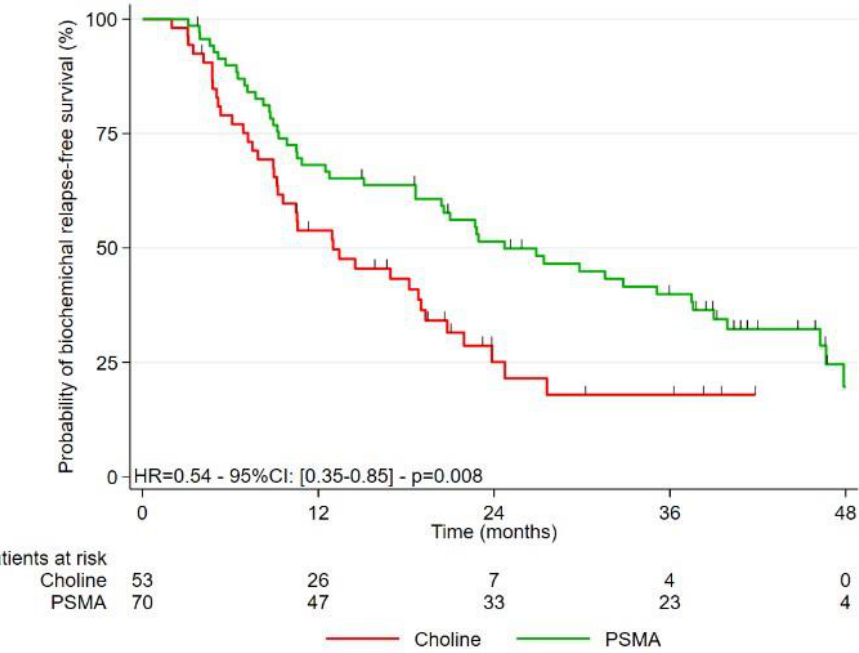
Figure 1. Kaplan-Meier curves for biochemical recurrence-free survival (BR-FS). Patients in the PSMA-PET group also had longer ADT-FS than patients in the FCH- PET group ( p = 0.001). ADT-FS rates at 2 years and 3 years were 75.9% (95%CI: 63.7–84.5) and 65.5% (95%CI: 52.3–75.8) compared to 49.7% (95%CI: 34.5–63.3) and 24.7% (95%CI: 9.6–43.4), respectively in the PSMA-PET and FCH-PET groups ( p = 0.001).